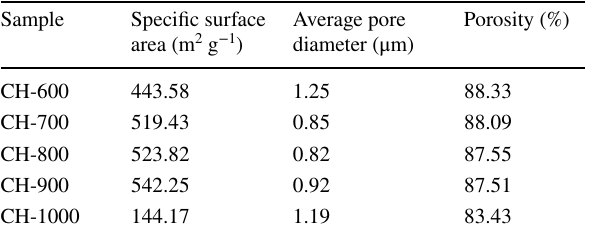
Table 1 Microstructural parameters of the hemp-stem-derived porous biochars